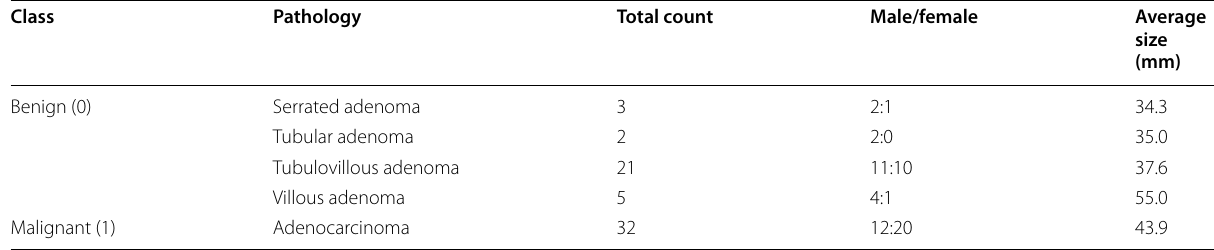
Table 1 Characteristics of polyp data set